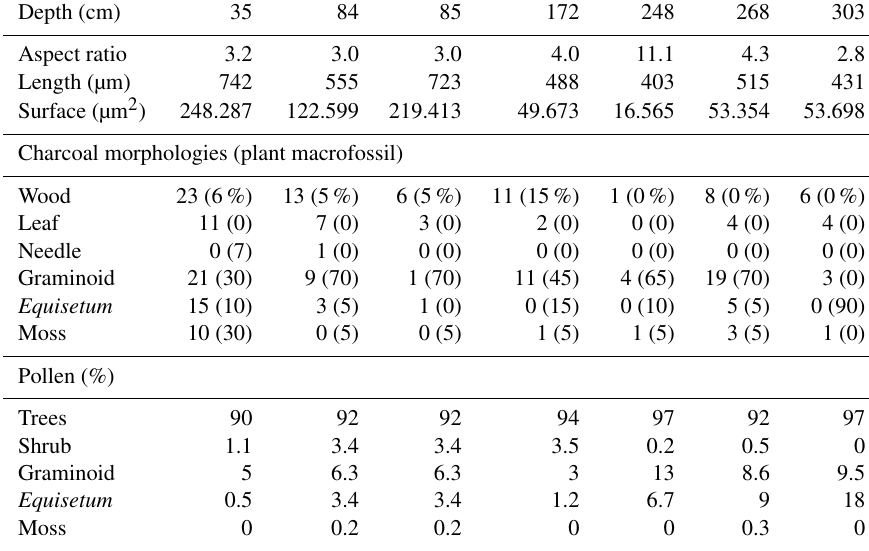
Table 3. The mean aspect ratio, length, surface area, and the number of each charcoal morphotypes in the Holocene samples ranging from 185 to 6750calyrBP (35–303cm) from Ulukh-Chayakh mire. The local to regional vegetation is represented by the percentages of the main pollen types, whereas the local vegetation is represented by the plant macrofossils (values in parentheses are presented as numbers except for the wood remains, which are presented as